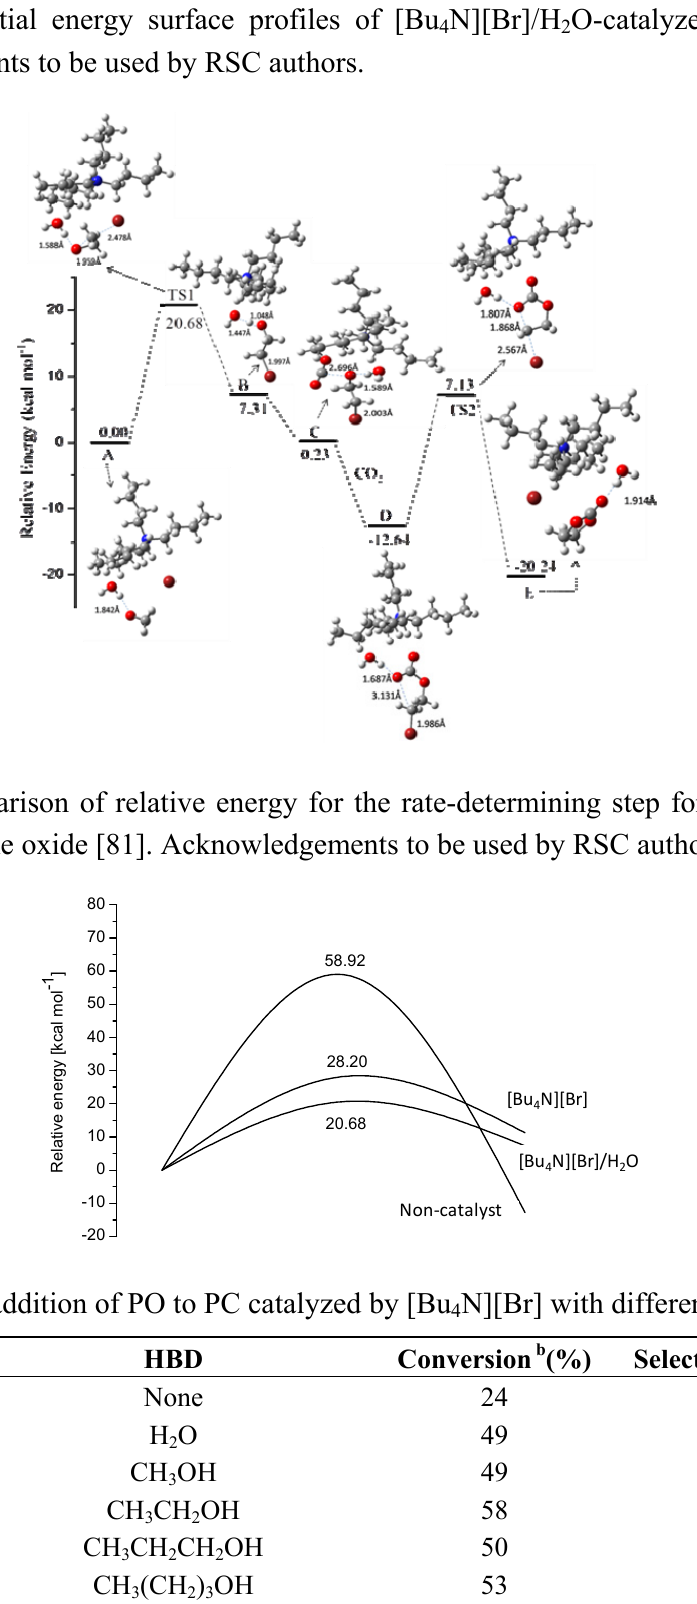
N][Br]/H O-catalyzed process [81]. 4 2